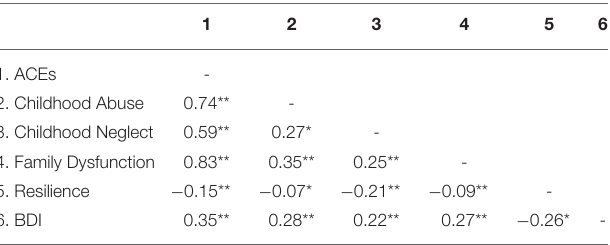
TABLE 2 | Correlations among ACEs, resilience, and